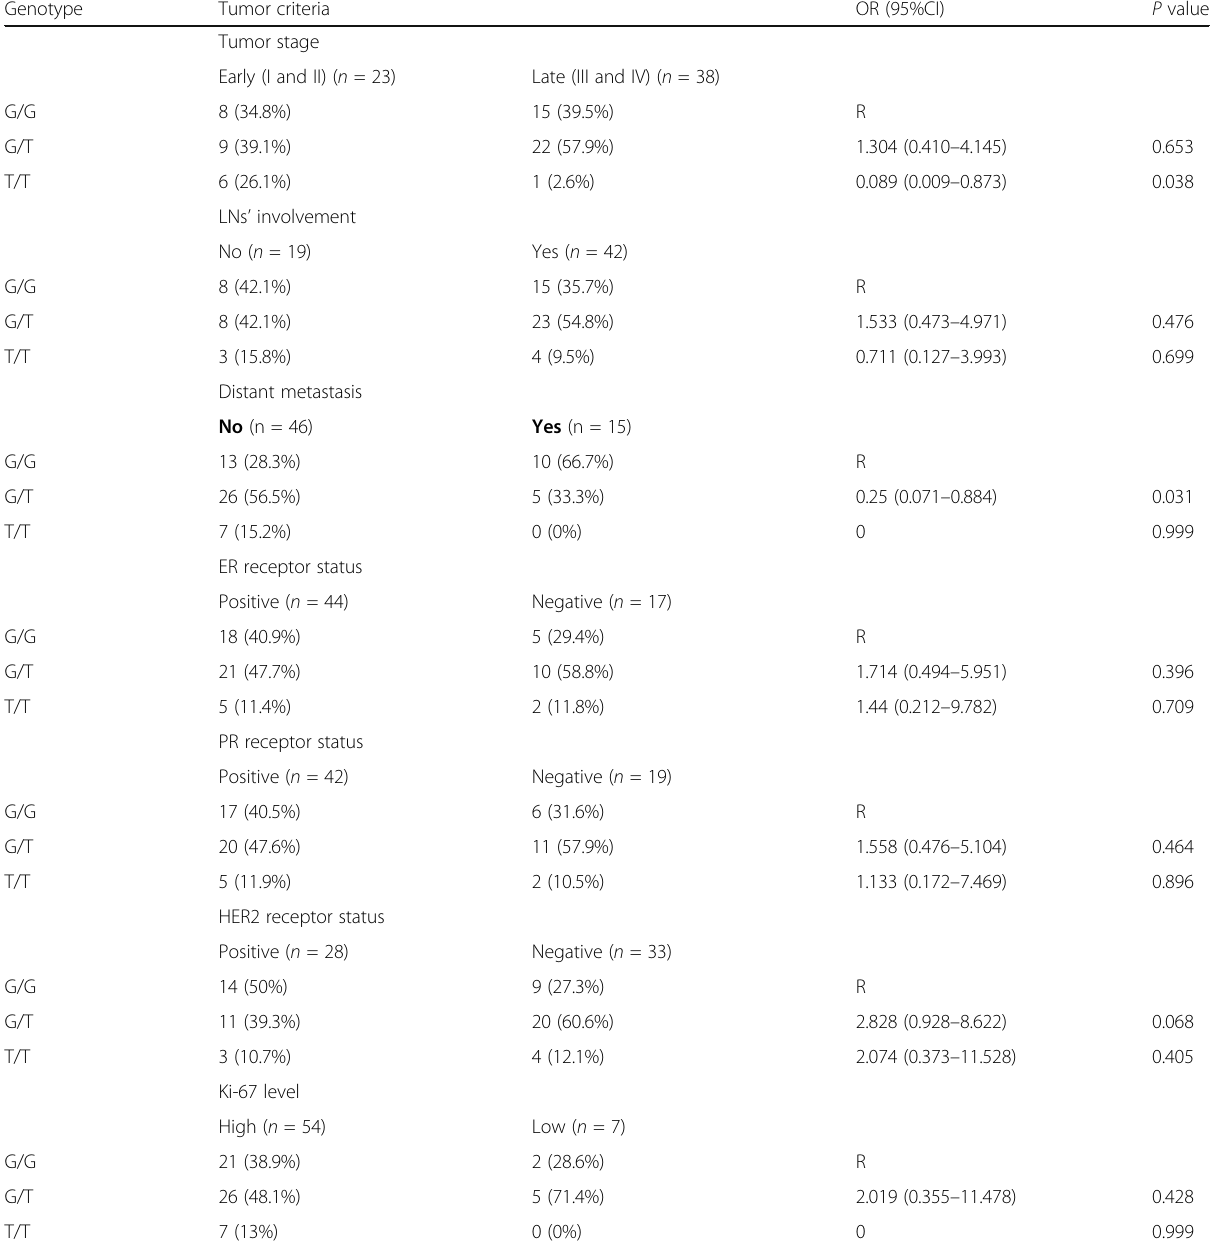
Table 4 Association between genotypes of NME1 EcoR1 (rs34214448) polymorphism and tumor criteria in the breast cancer group